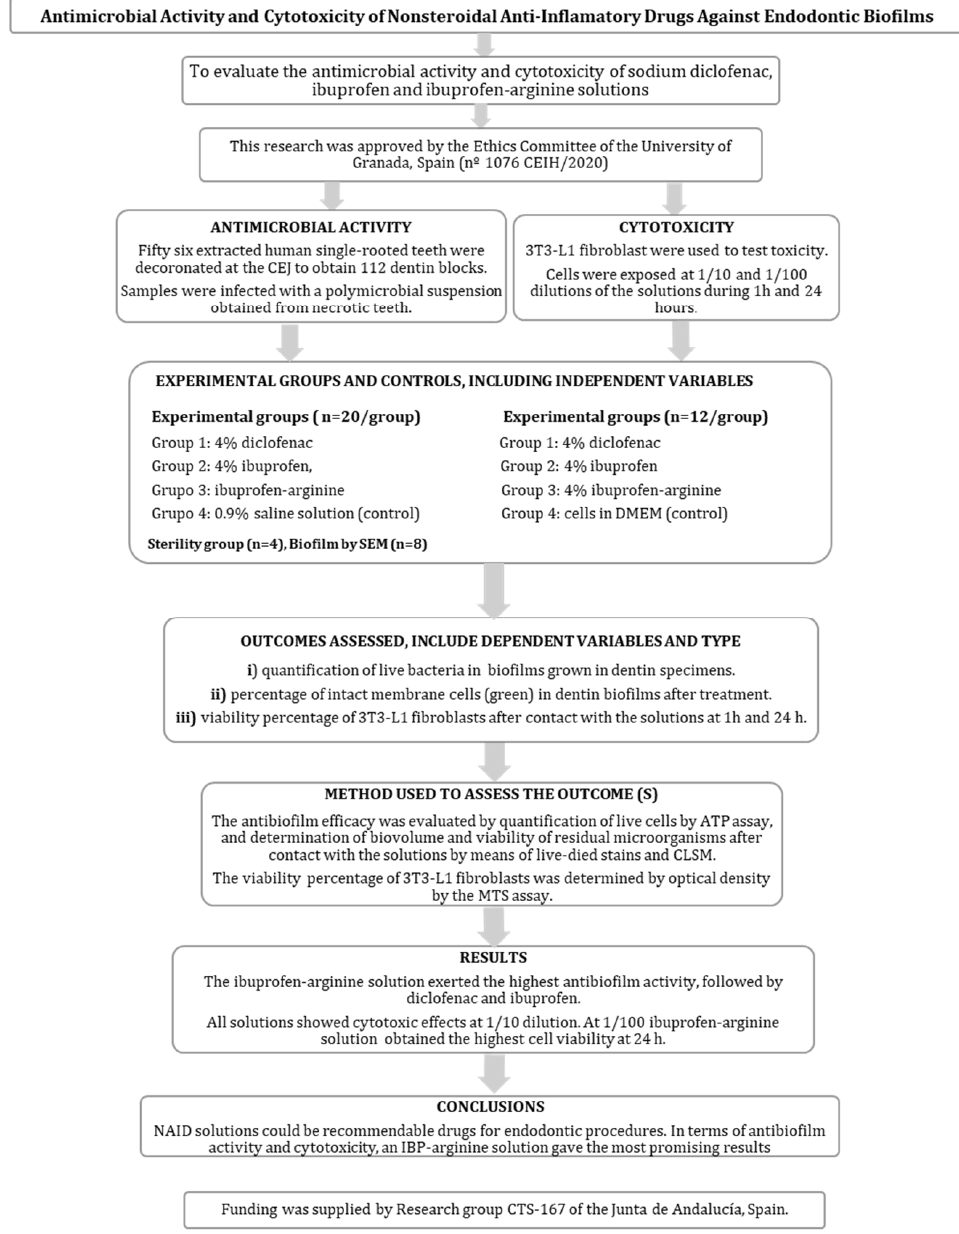
Figure 3. PRILE 2021 flowchart.